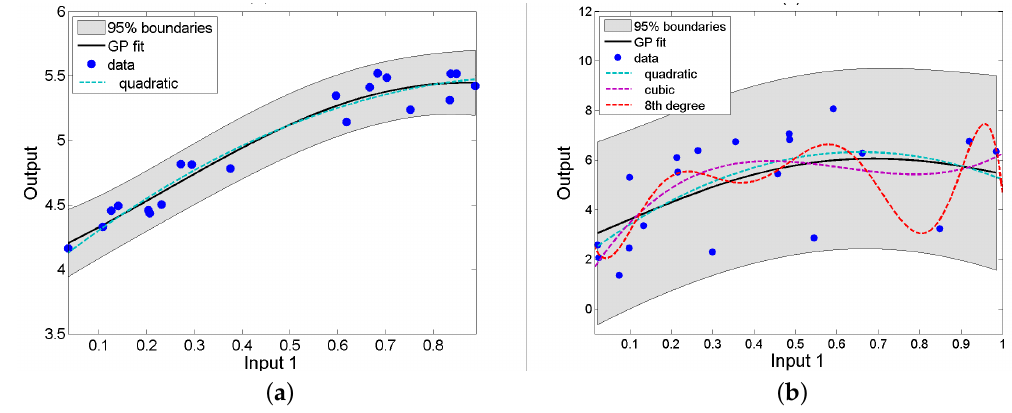
Figure 3. Gaussian processes regression and polynomial fits for two different levels of noise: ( a ) 0.02 and ( b ) 1.12.